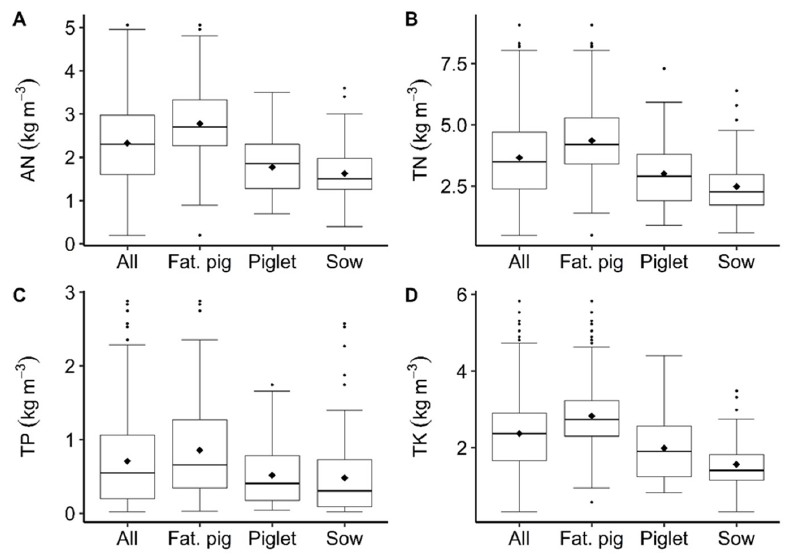
Figure 1. Slurry nutrient concentrations of AN ( A ), TN ( B ), TP ( C ), and TK ( D ). “All” (n = 391), “Fattening pig” (n = 232), “Piglet” (n = 49) and “Sow” (n = 110) denote either the entire data set or the respective subsets contained therein. Mean values shown by diamonds.